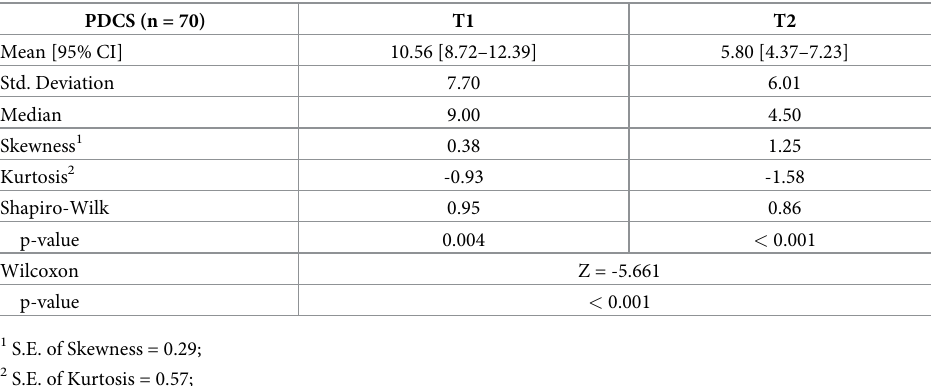
Table 3. Descriptive statistics for the PDCS (across T1 and